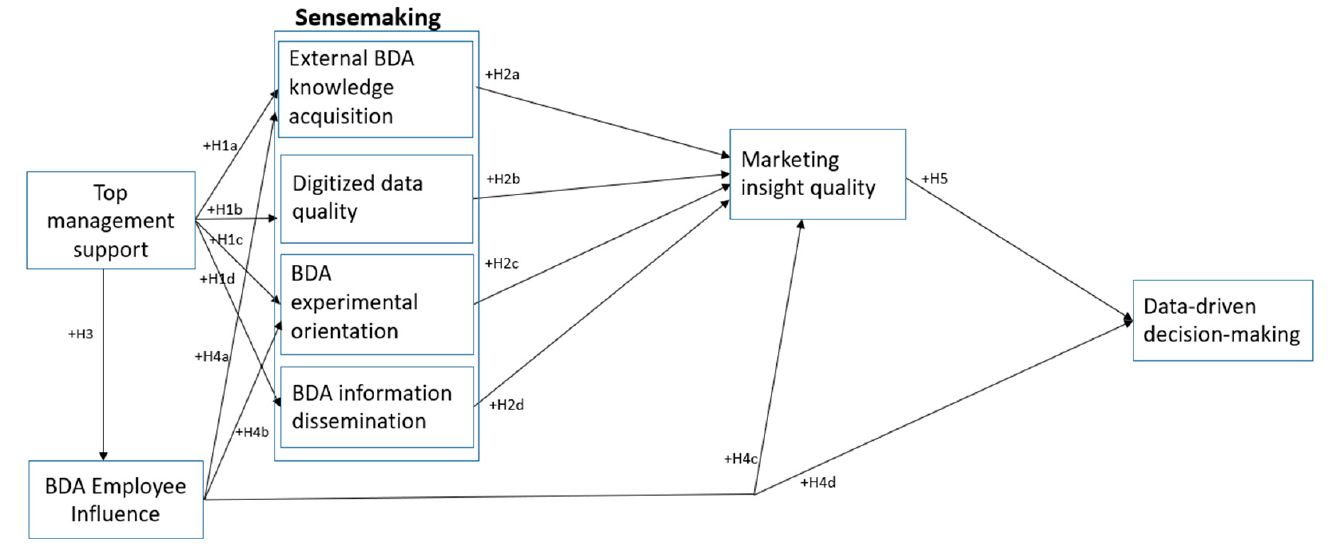
Figure 1. Marketing BDA Sensemaking and Data Driven Marketing.